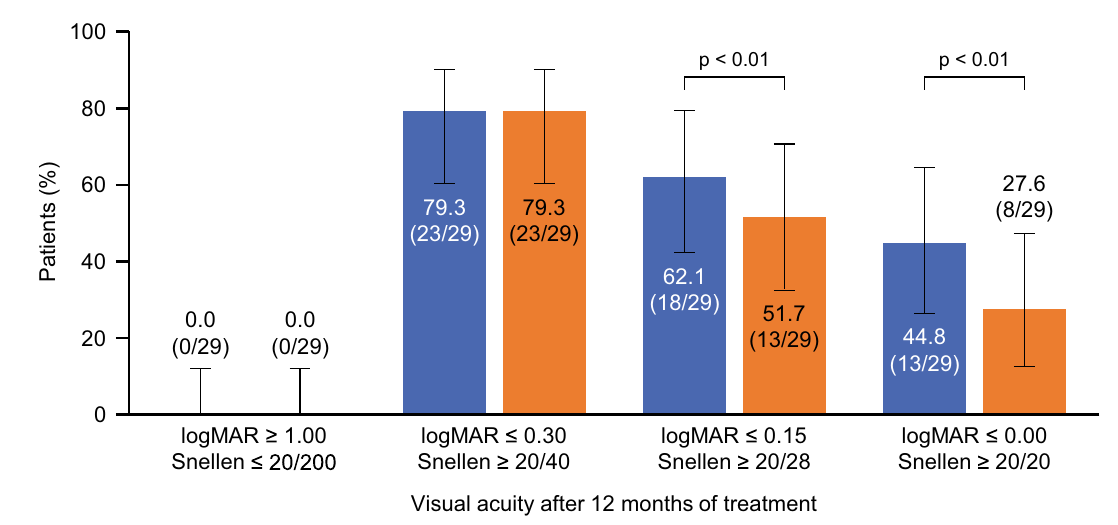
Figure 6. Overall visual acuity performance by treatment group analyzed by logMAR conversion. Number of injections per year: p < 0.01; 1 injection vs 3; t -test by Tukey’s method. Error bars represent 95% confidence intervals. logMAR logarithm of the minimum angle of resolution, RBZ ranibizumab, Snellen Snellen visual